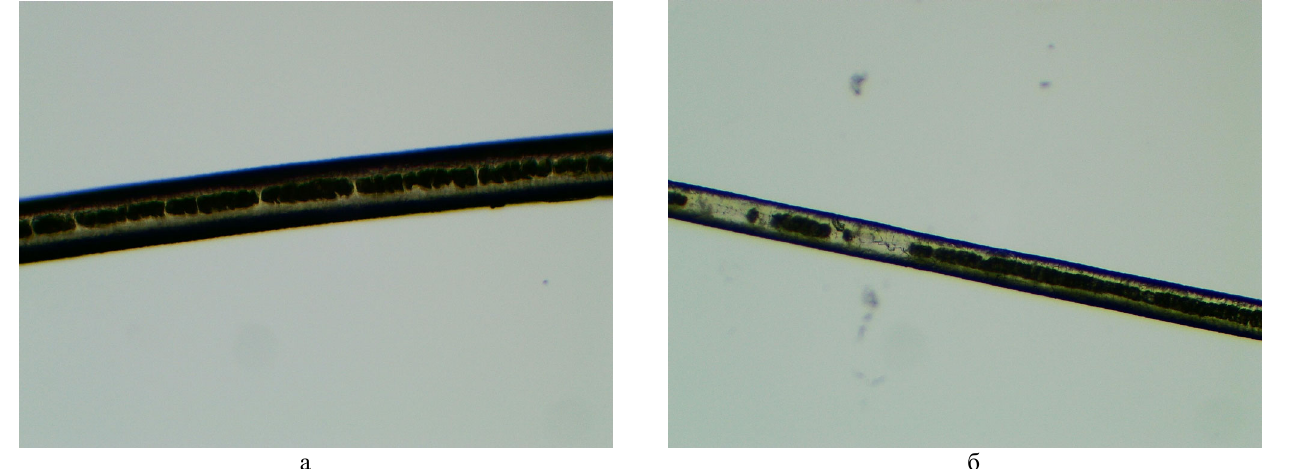
Figure 3. Horse hair ( Equus caballus ): а – male; b – covering hair; х 400.